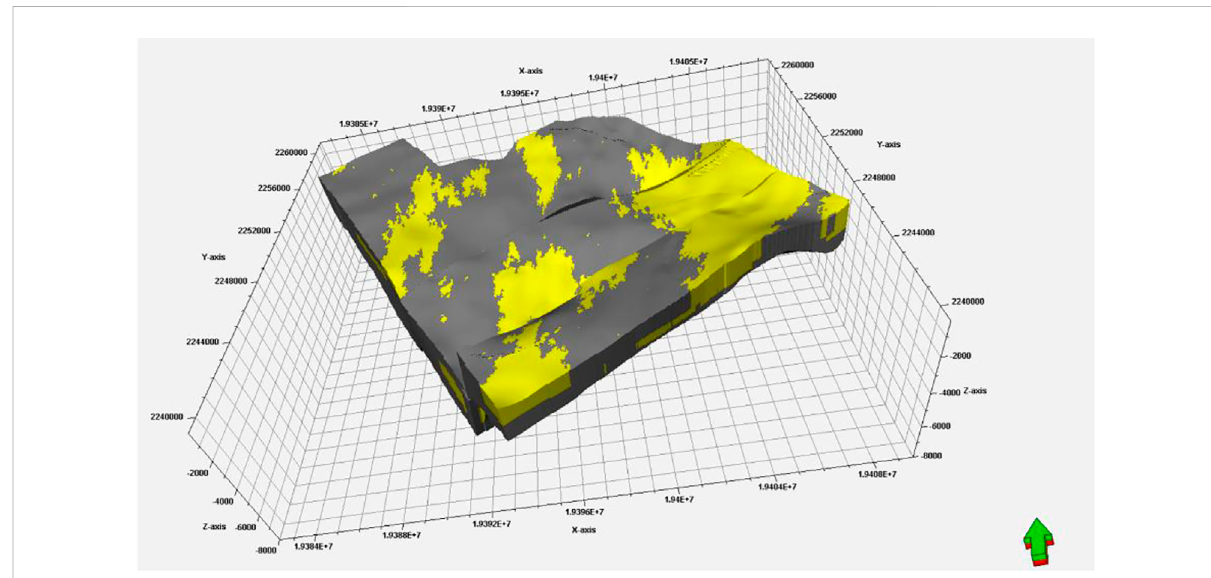
FIGURE 7 Lithological model of Weizhou and Liushagang layers of the research area (the yellow area is sand and the dark gray area is